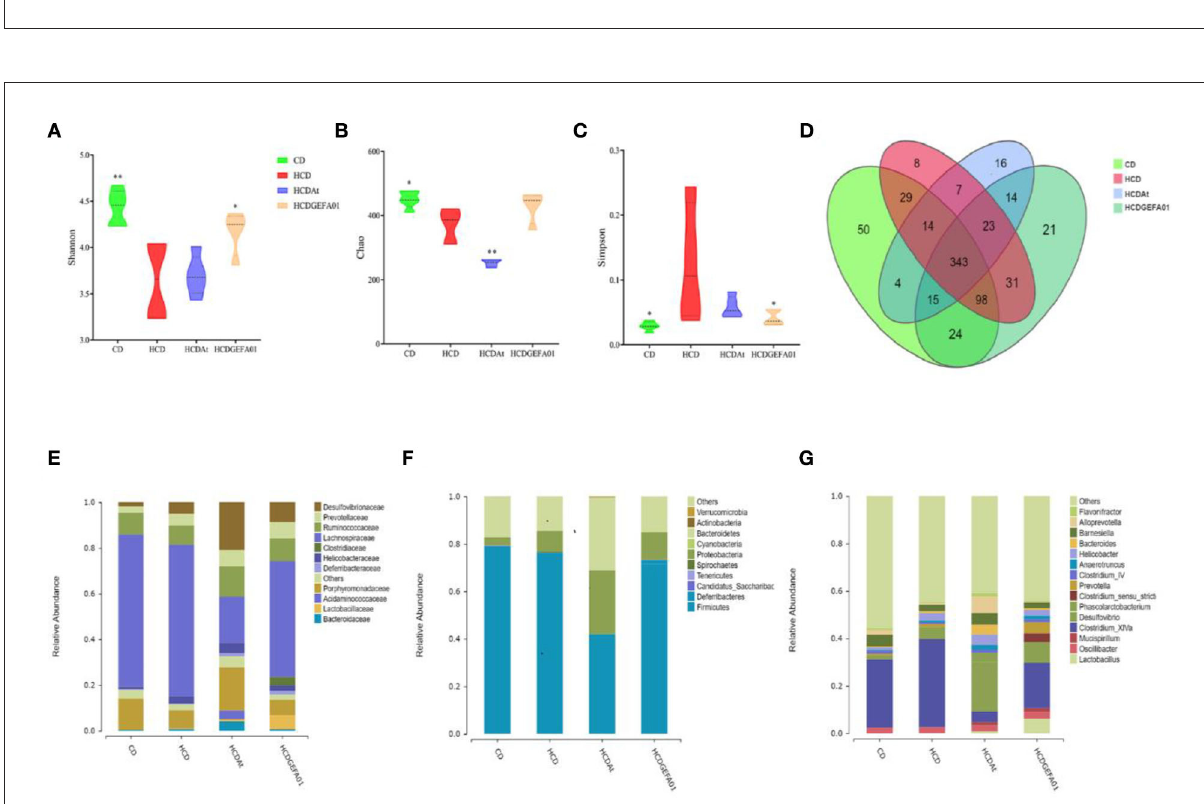
FIGURE6 E. faecium GEFA01 increased fecal acetate and bile acid level of hypercholesterolemic mice. (A) Short-chain fatty acid (SCFA) contents in feces and (B) total bile acid contents in feces. Data were expressed as mean ± SEM: n = 4 animals per group; * p < 0.05, ** p < 0.01, *** p < 0.001, all groups were compared to the HCD group.